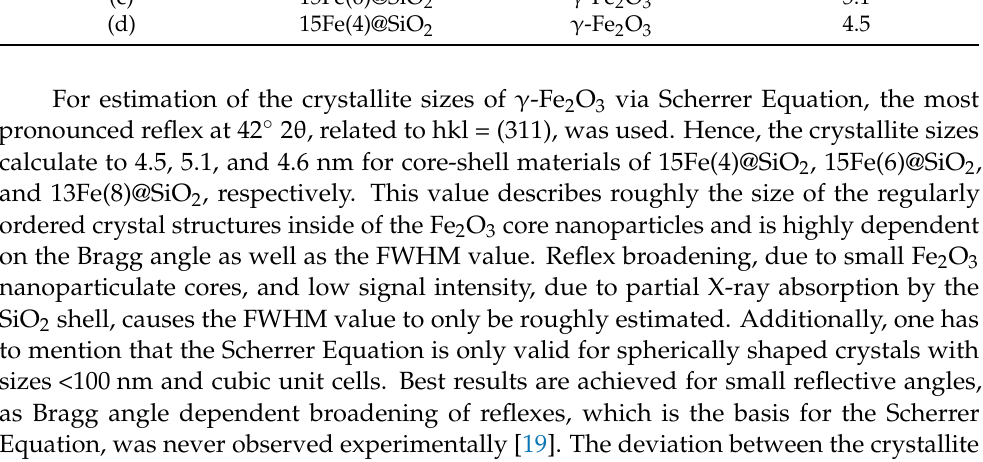
Table 2. Fe crystallite phase derived from PXRD and average crystallite size d cryst of γ -Fe 2 O 3 at